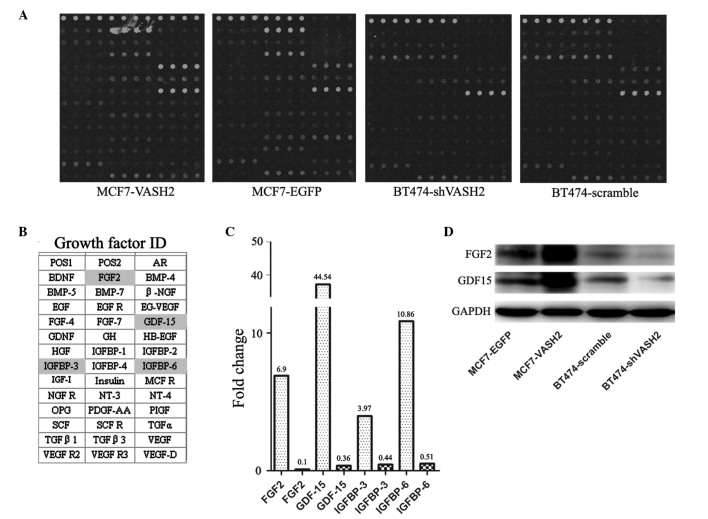
Human growth factor array and verification of positive hits. (A) Dots on human growth factor antibody arrays. (B) Names of the tested angiogenic factors. Growth factor fold changes of >1.5 in VASH2-overexpressing cells or <0.66 in VASH2 knockdown cells were selected as up- and downregulated, respectively (highlighted). (C) Distinct fold change of four growth factors: FGF2, GDF15, IGFBP3 and IGFBP6. (D) Immunoblot analysis of FGF2 and GDF15. VASH2; vasohibin-2; EGFP, enhanced green fluorescent protein; AR, androgen receptor; BDNF, brain-derived neurotrophic factor; FGF, fibroblast growth factor; BMP, bone morphogenetic protein; EGF, epidermal growth factor; GDF, growth/differentiation factor; HB-EGF, heparin binding-EGF; IGFBP, insulin-like growth factor-binding protein; VEGF, vascular endothelial growth factor.